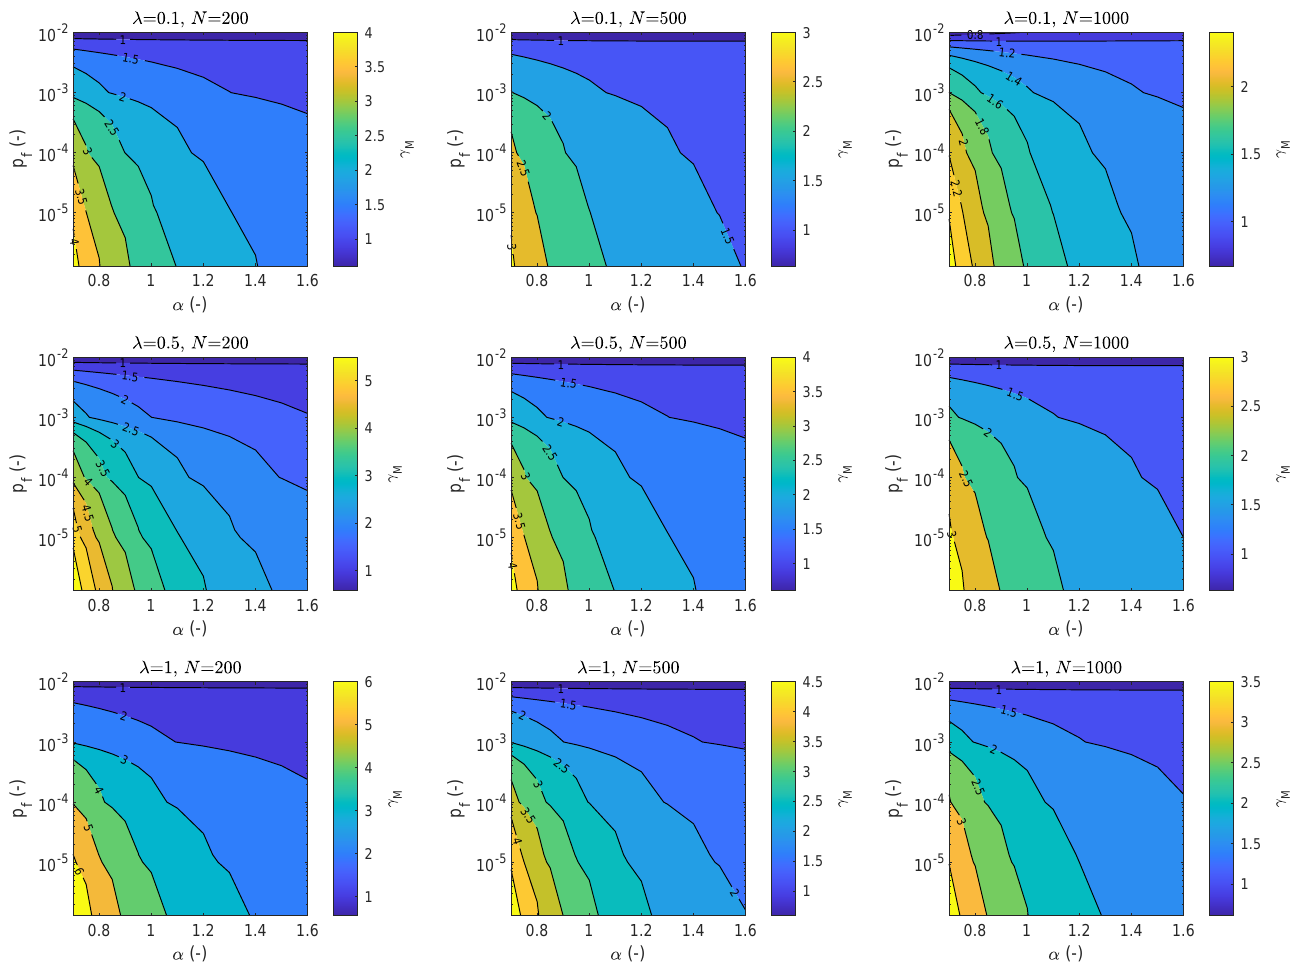
Figure A2. Partial safety factor related to the mass, γ m , for variable failure probabilities considering a reference block mass having a return period T k = 200